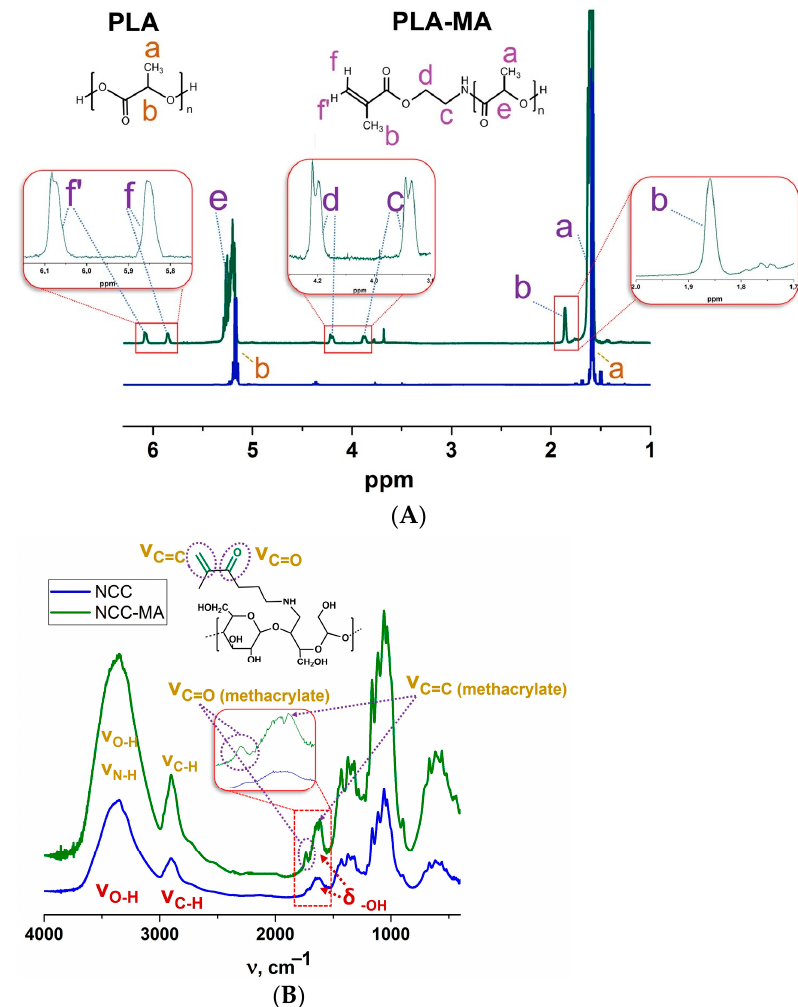
Figure 3. The evidence for successful introduction of methacrylate groups into particles under study: ( A ) 1 H NMR spectra of PLA and PLA-MA particles dissolved in CDCl 3 ; ( B ) FTIR spectra of NCC and NCC-MA.